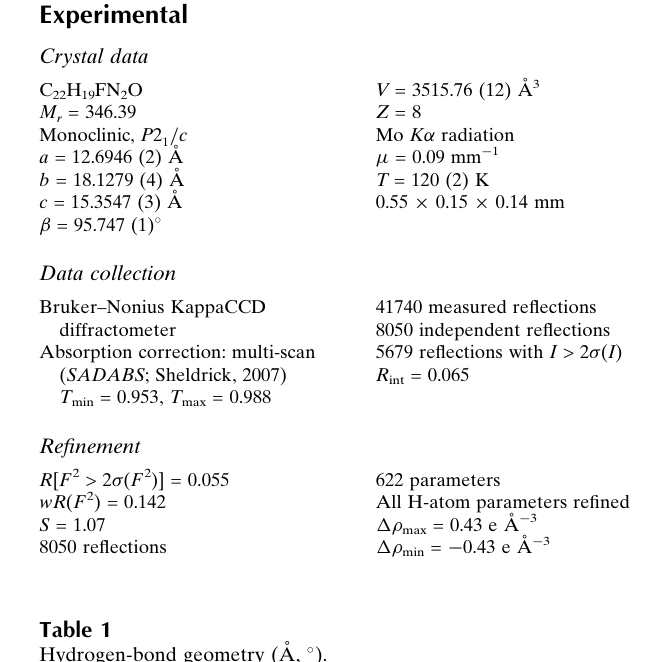
Hydrogen-bond geometry (A˚ , (cid:1)